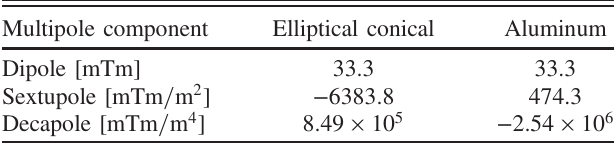
TABLE III. A table of the multipolar components of the elliptical conical and Aluminum cavity designs, normalized to a transverse voltage of 10 MV.